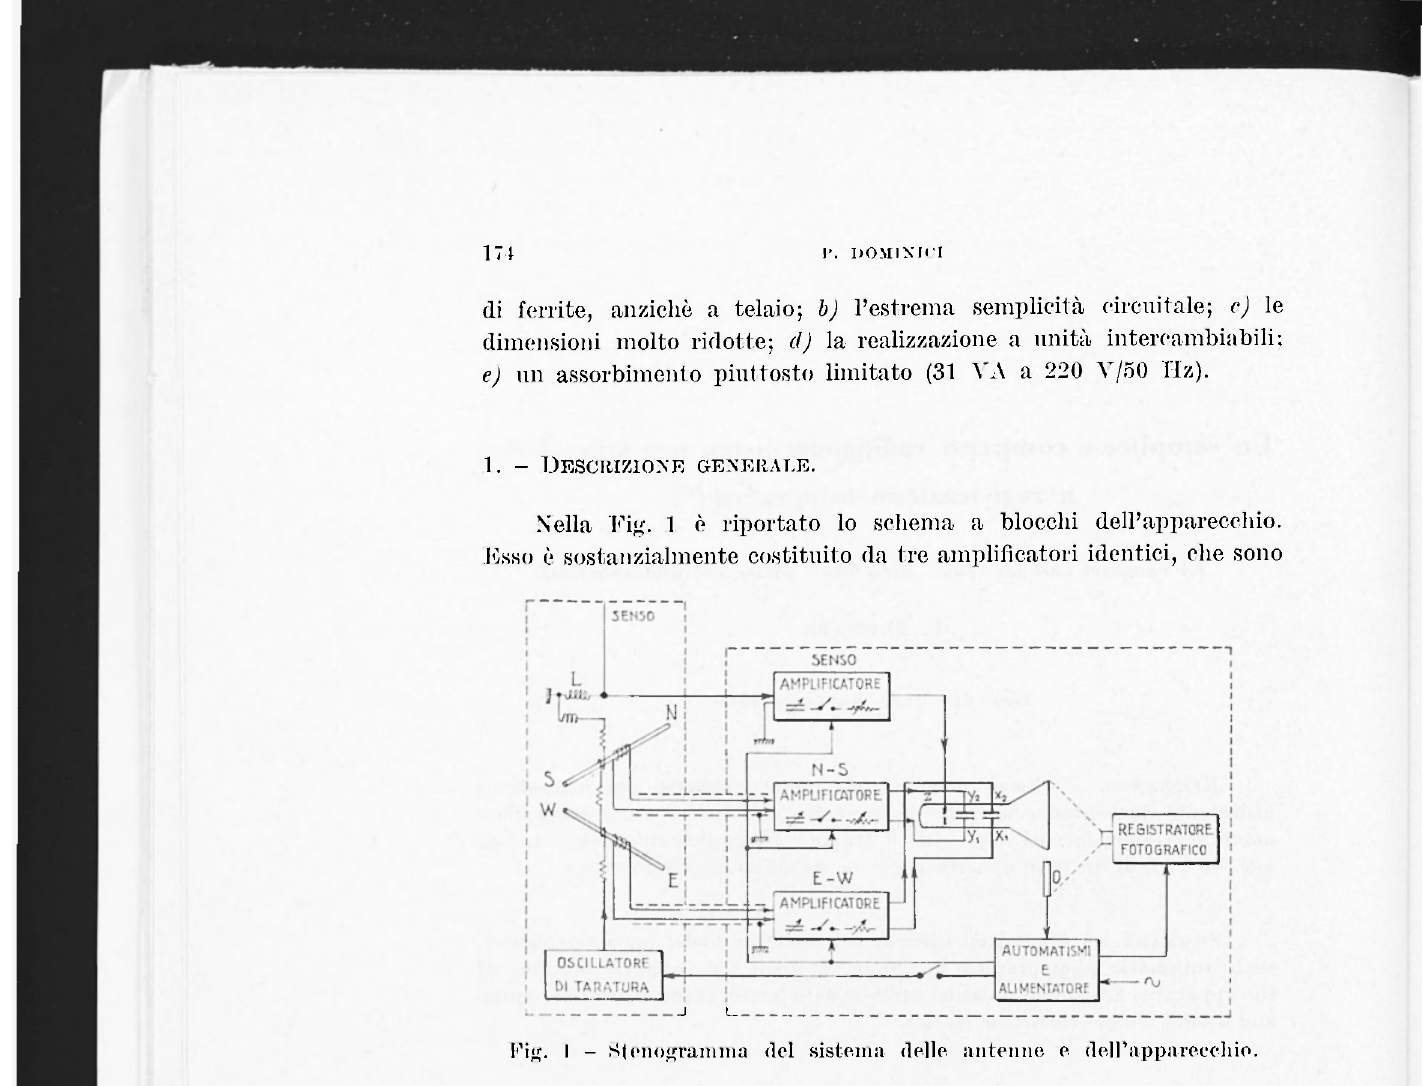
Fig. 1 - Stenogramma del sistema delle antenne e dell'apparecchio. alimentati, rispettivamente, da un'antenna omnidirezionale (antenna